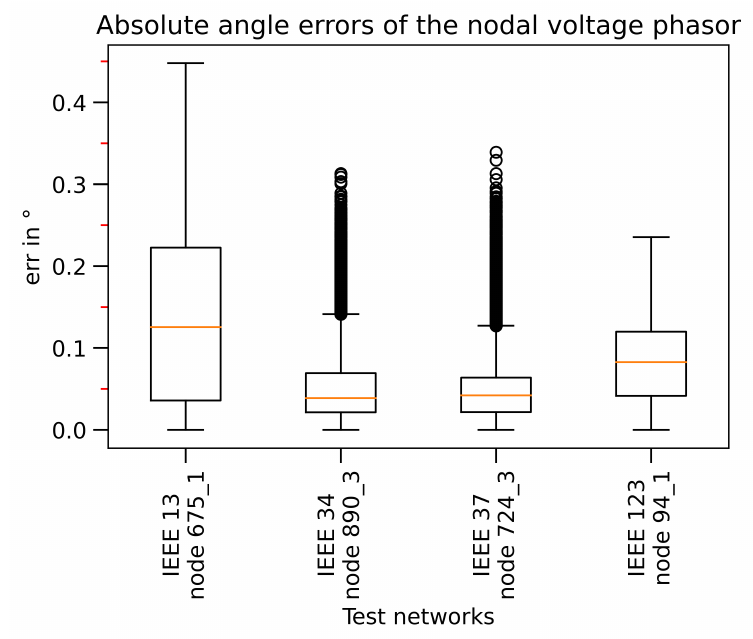
Figure 14. Distribution of absolute errors of nodal voltage phasor angles for nodes with the highest errors (scenario considering the load